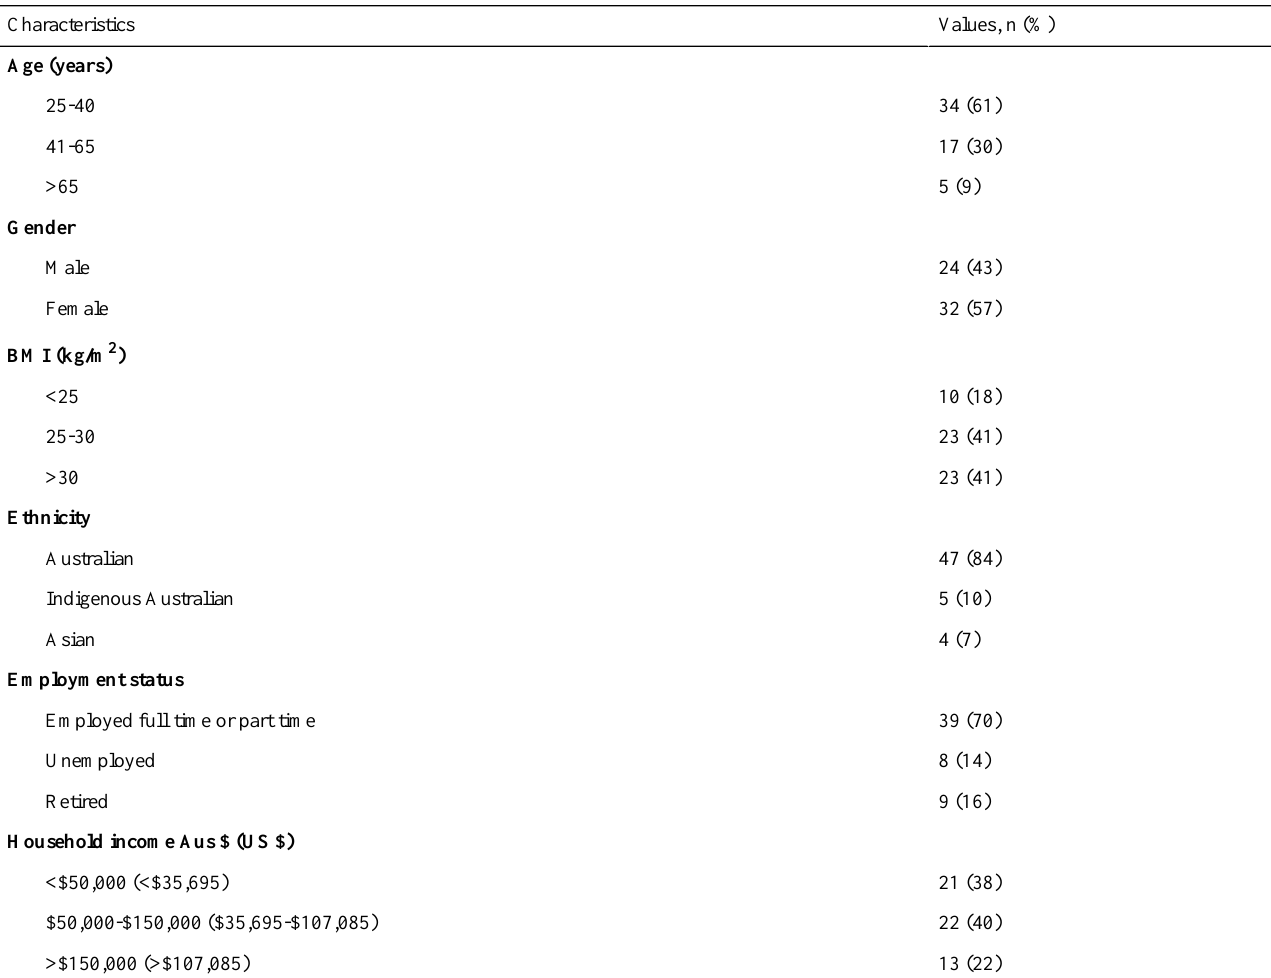
Table 2. Characteristics of interview participants